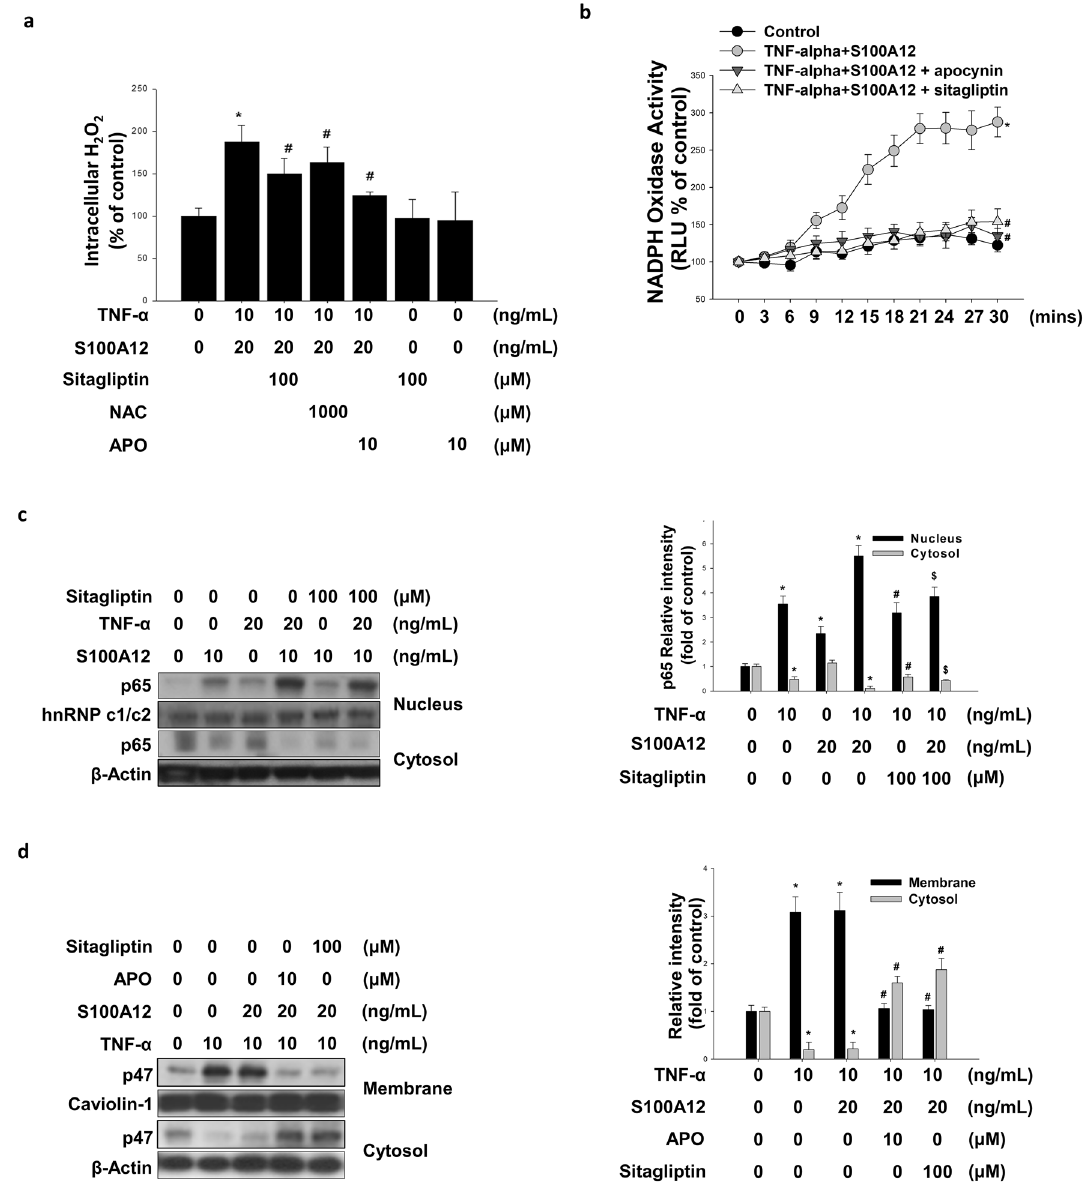
Figure 4. Sitagliptin attenuated TNF-α combination with S100A12-induced oxidative stress, NF-κB, and p47 activation in HASMCs. (a) HASMCs were cultured in an osteogenic differentiation medium for 1 day in the presence or absence of TNF-α combined with S100A12 concomitant with sitagliptin (50 µM), APO (apocynin: 500 µM; Nox inhibitor). Intracellular hydrogen peroxide generation was assessed by DCF-AM staining. (b) Nox activity was evaluated by lucigenin chemiluminescence. (c) The expression level of NF-κB subunit p65 (nucleus and cytosol fraction) was assessed by Western blotting. hnRNP c1/c2 was used as a nucleus fraction loading control. (d) The expression level of Nox subunit p47 (membrane fraction) was assessed by Western blotting. Caveoli-1 was used as a membrane fraction loading control. * P < 0.05 compared with the control group, and # P < 0.05 compared with the TNF-α combined with S100A12 groups. N = 6 for each set of reduced osteogenic programming and calcification 23 . The signaling of S100A12 was controlled by the presence of RAGE and oxidative stress signaling. In this study, HFD-induced the mice hyperglycemia and dyslipidemia con- tributed to arterial calcification, whereas these were significantly downregulated after 24 weeks-treated sitagliptin (Fig. 1b, Table 1). A previous study showed that sitagliptin attenuated body weights and reduced local inflamma- tion in adipose tissue of HFD-induced obese mice 45 . We suggested that sitagliptin decreased body weight gain by attenuating the levels of TNF-α and TG (Fig. 1a, Table 1). Moreover, DPP4 induced valvular calcification and promoted calcific aortic valve disease progression by inhibiting autocrine insulin-like growth factor-1 (IGF-1) signaling. Treatment with sitagliptin reduced the calcium deposits and increased plasma IGF-1 levels 46 . In our study, sitagliptin significantly reduced HFD-induced DPP4 activity consequently attenuated arterial calcifica- tion in LDLR −/− mice (Fig. 1c,d). GLP-1 was known to be involved in anti-inflammation 47 . Sitagliptin dietary